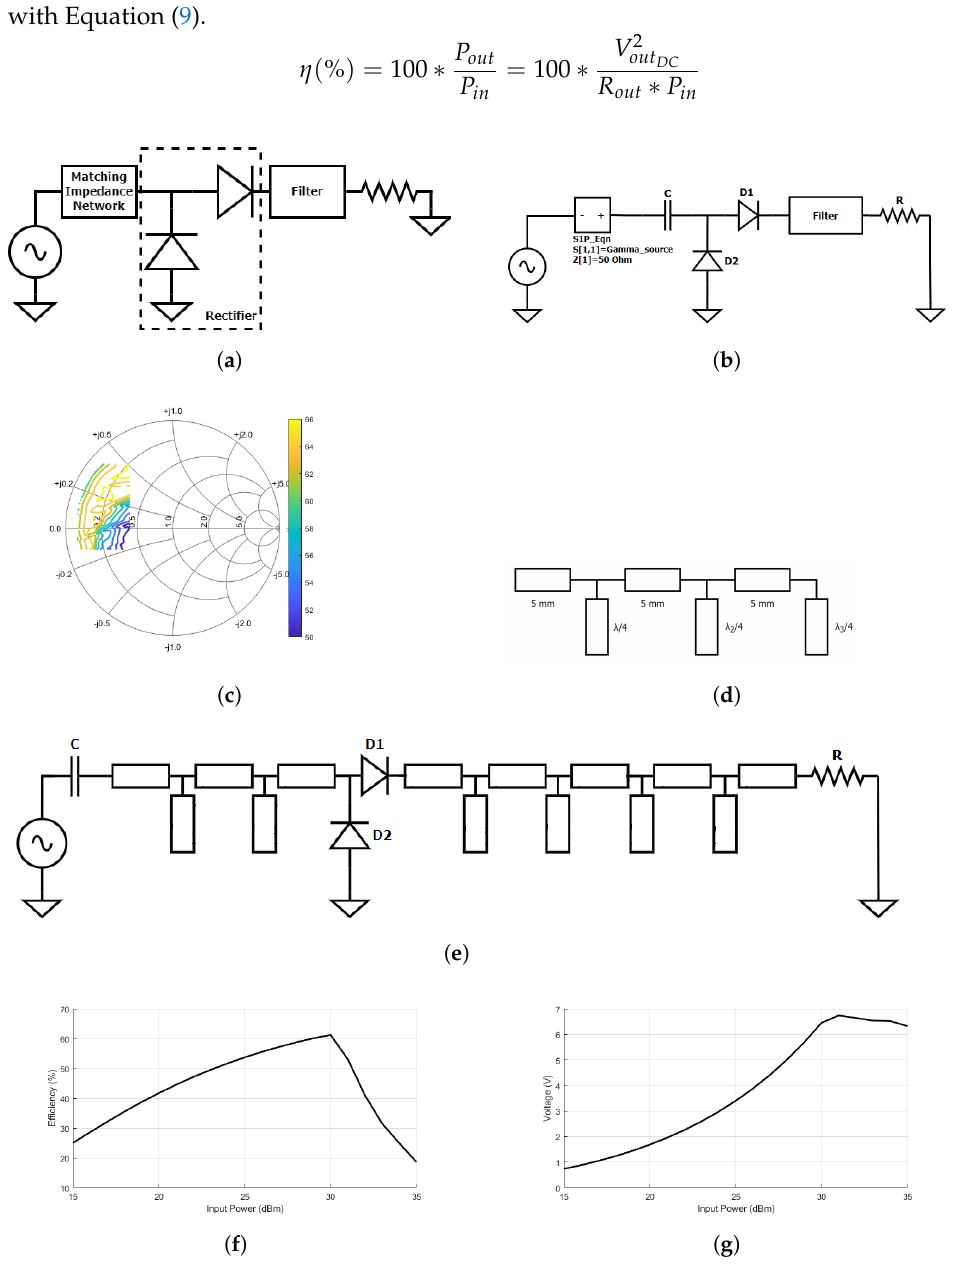
Figure 5. High Power and Efficient RF-DC Converter Step-by-Step Design. ( a ) RF-DC converter block diagram. ( b ) Schematic of the source and load pull simulation used in ADS. ( c ) Source-pull simu- lation. ( d ) Class-R filter Block Diagram. ( e ) Schematic of the RF-DC converter. ( f ) Simulated efficiency. ( g ) Simulated output